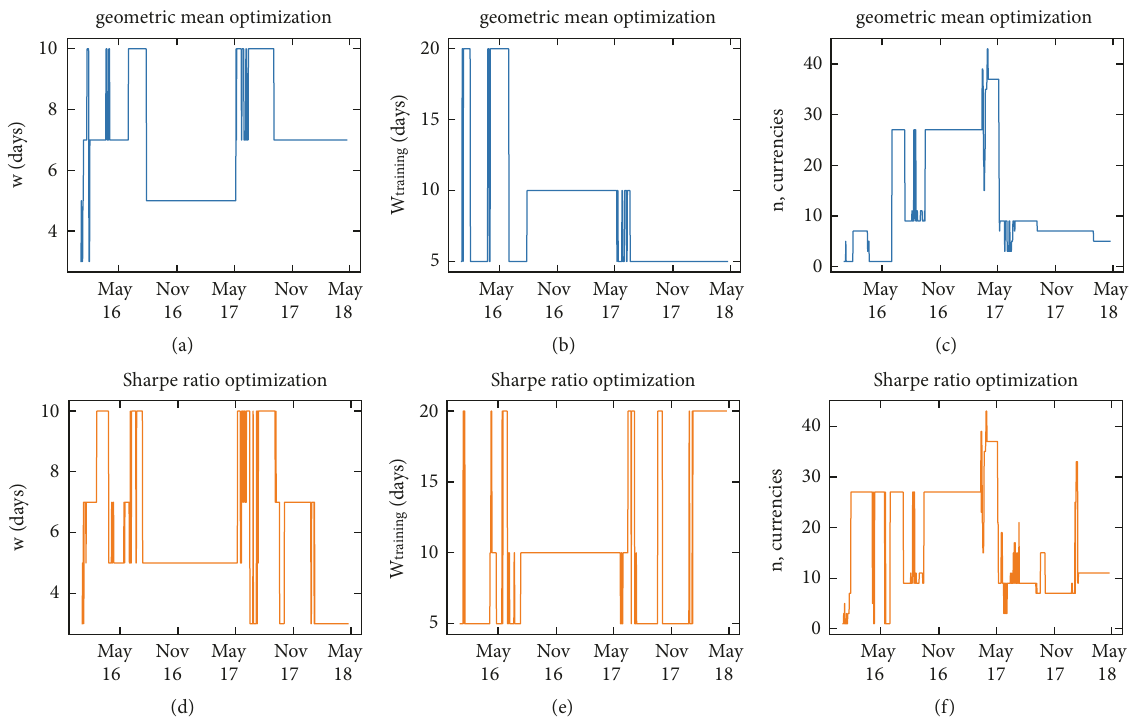
Figure9: Method1:parametersoptimisation. Theslidingwindow 𝑤 (a,d),thetrainingwindow 𝑊 𝑡𝑟𝑎𝑖𝑛𝑖𝑛𝑔 (b,e),andthenumberofcurrencies 𝑛 (c, f) chosen over time under the geometric mean (a, b, c) and the Sharpe ratio optimisation (d, e, f). Analyses are performed considering prices in